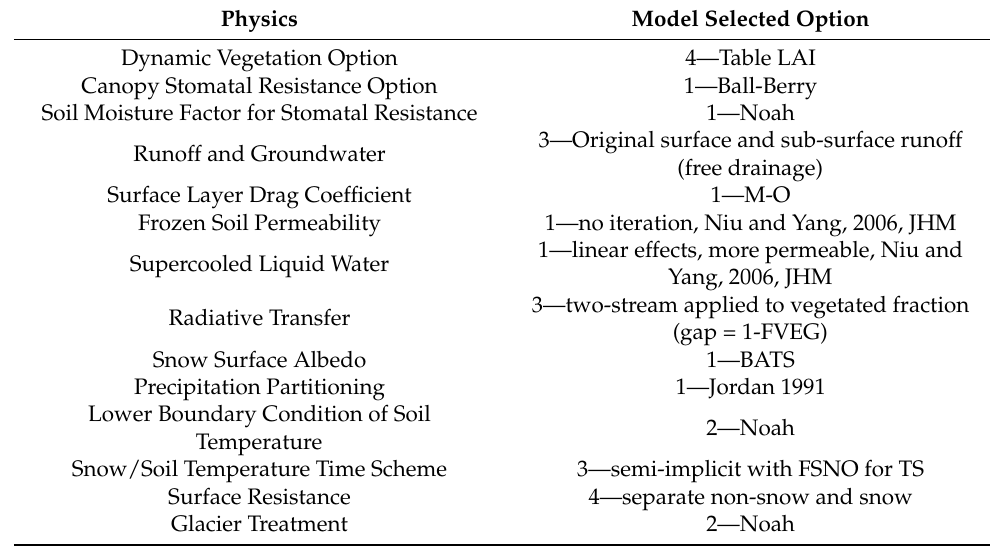
Table 2. Name list for physics options selected in